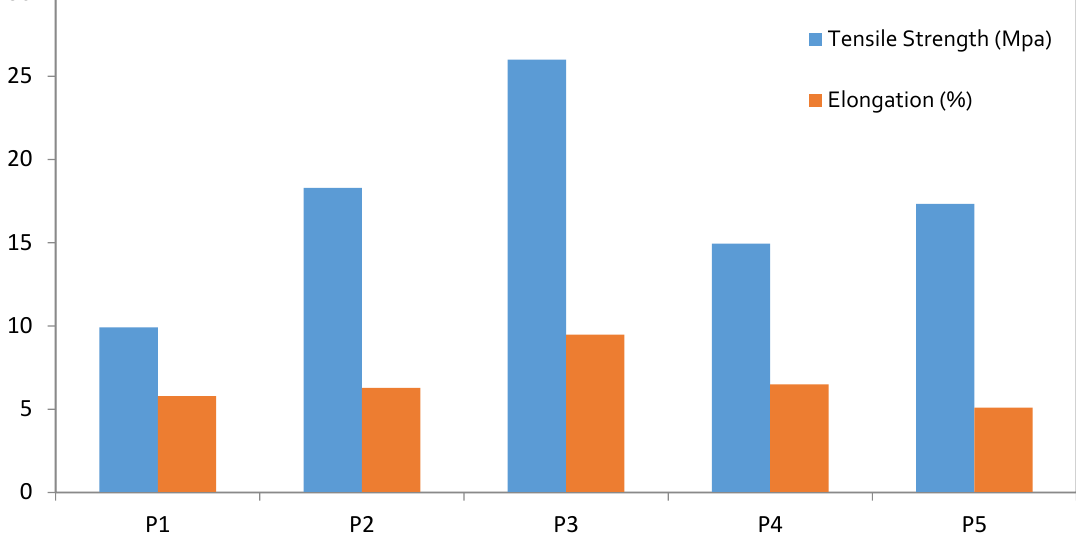
Figure 9. Effect of PES content on the mechanical properties of various PPSU-PES blend membranes. Figure 9. E ff ect of PES content on the mechanical properties of various PPSU-PES blend